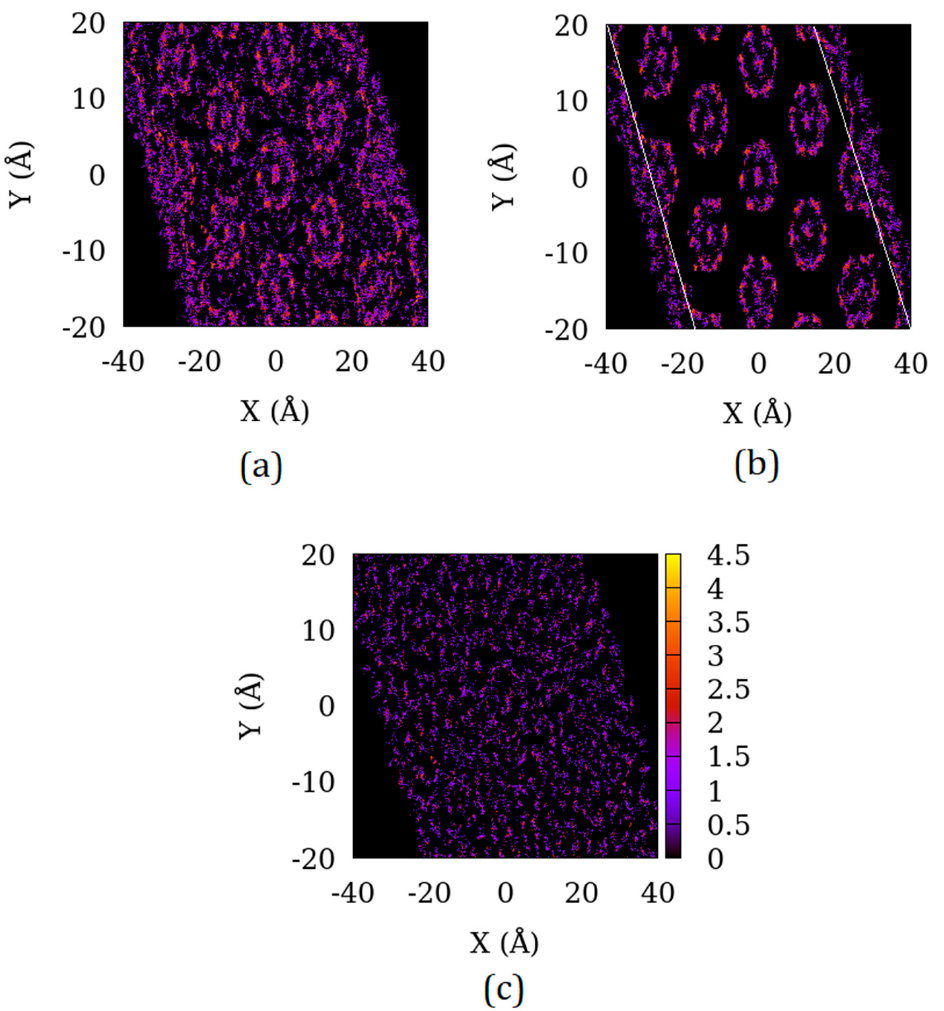
Figure 3. Distribution of the projection of center of mass of the adsorbed CO 2 molecules in the X–Y plane of ( a ) S4 sample ( b ) S4 sample with the adsorbed molecules outside the substrate in the Z-direction excluded and ( c ) S4 sample with the adsorbed molecules inside the substrate in the Z-direction excluded.